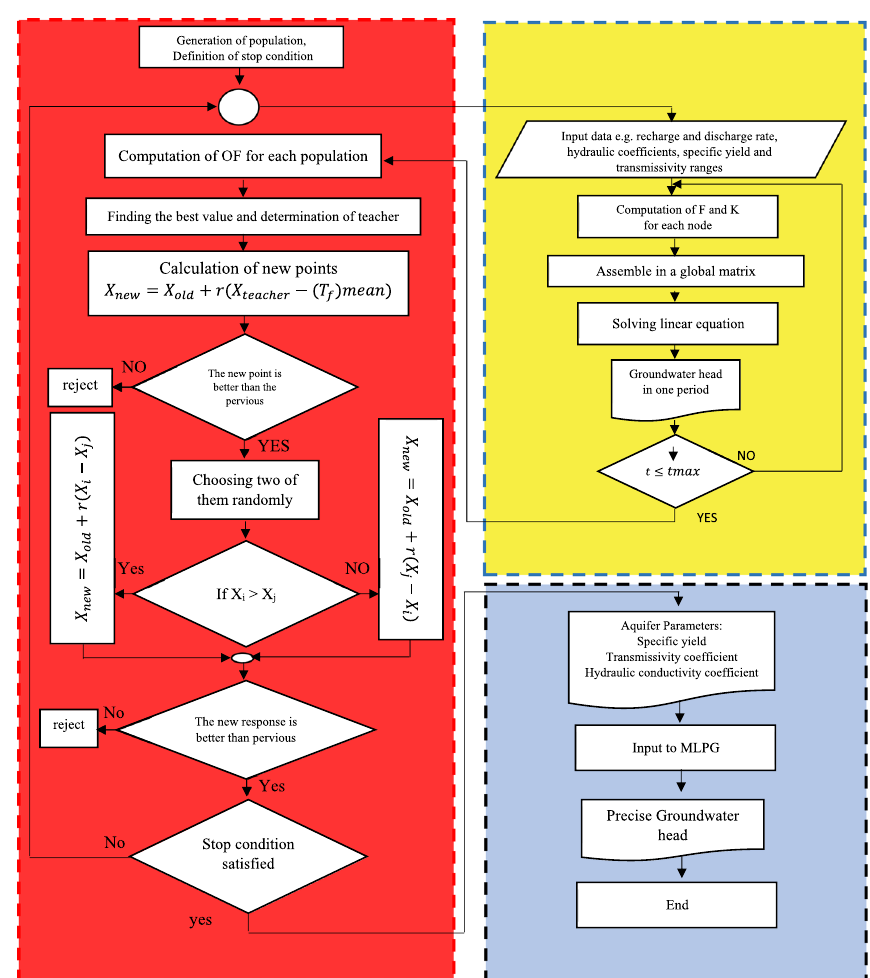
Fig. 1 Flowchart of MLPG- MTLBO